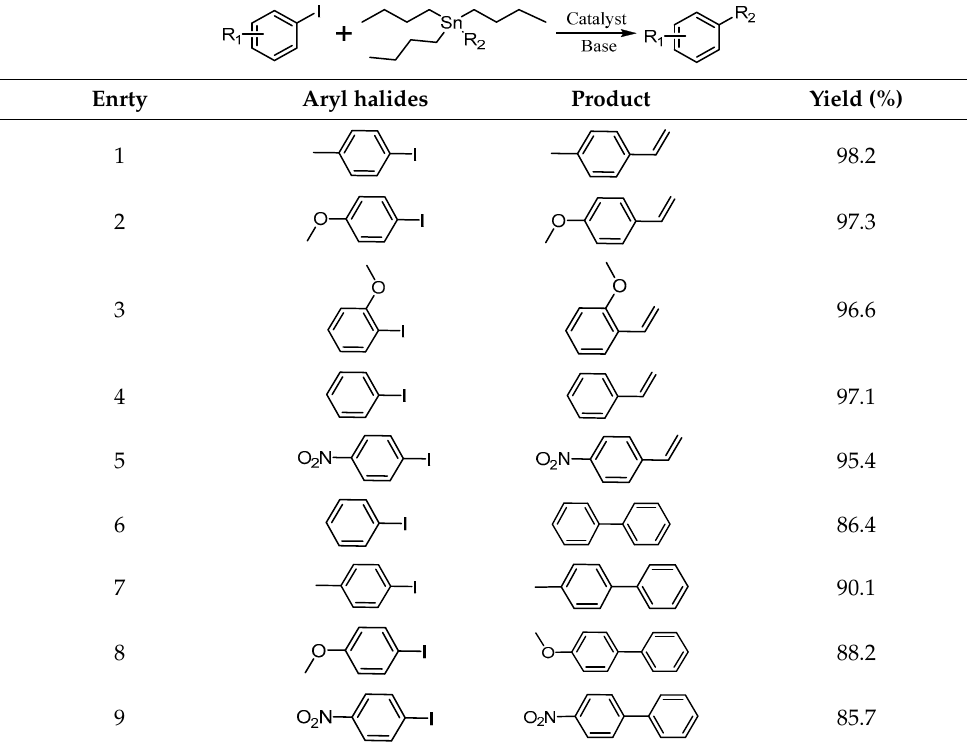
Table 1. Photocatalytic Stille Coupling Reactions of Various Aryl Halides over CPT-1.5.